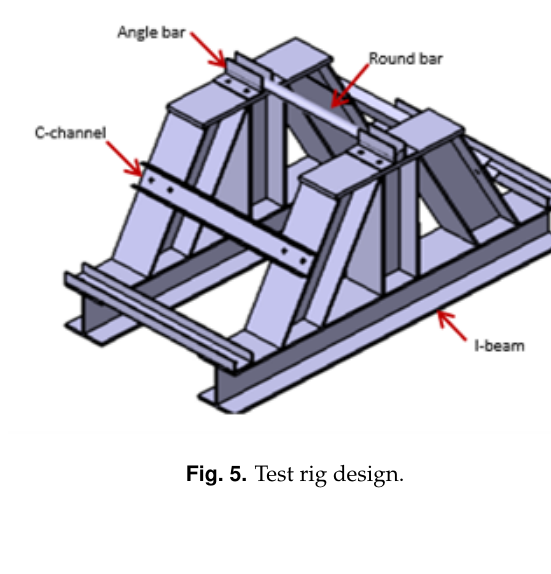
Fig. 5. Test rig design.